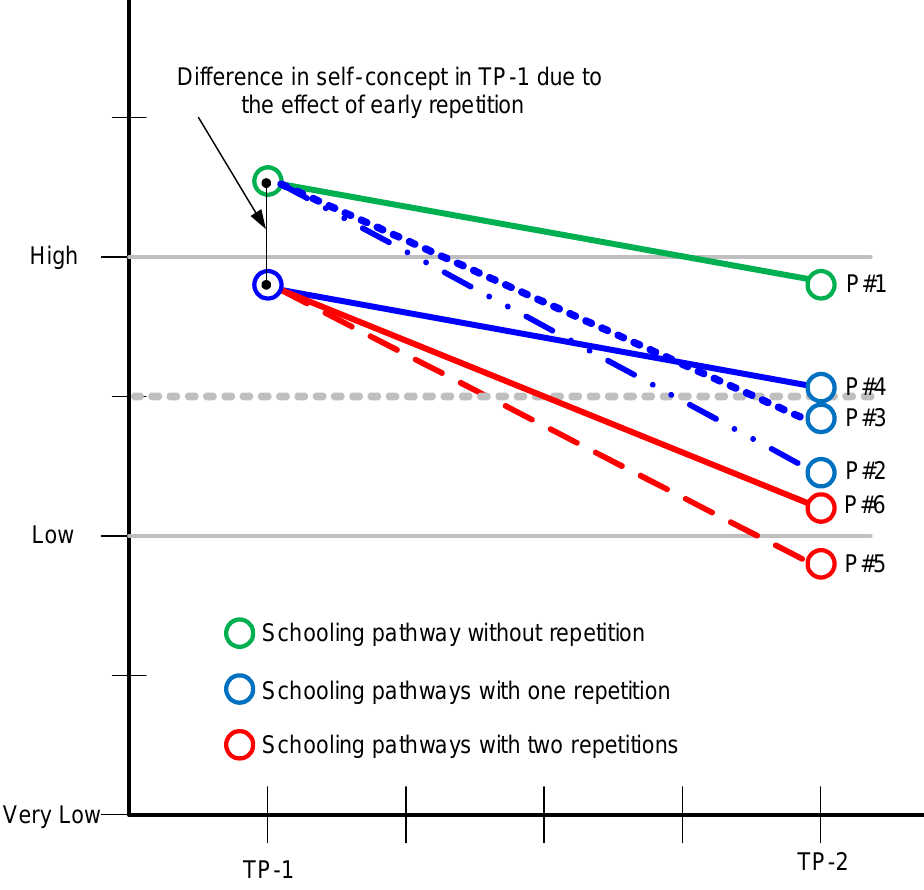
Figure 2. Progression of academic self-concept in relation to schooling pathways once background factors are controlled for.